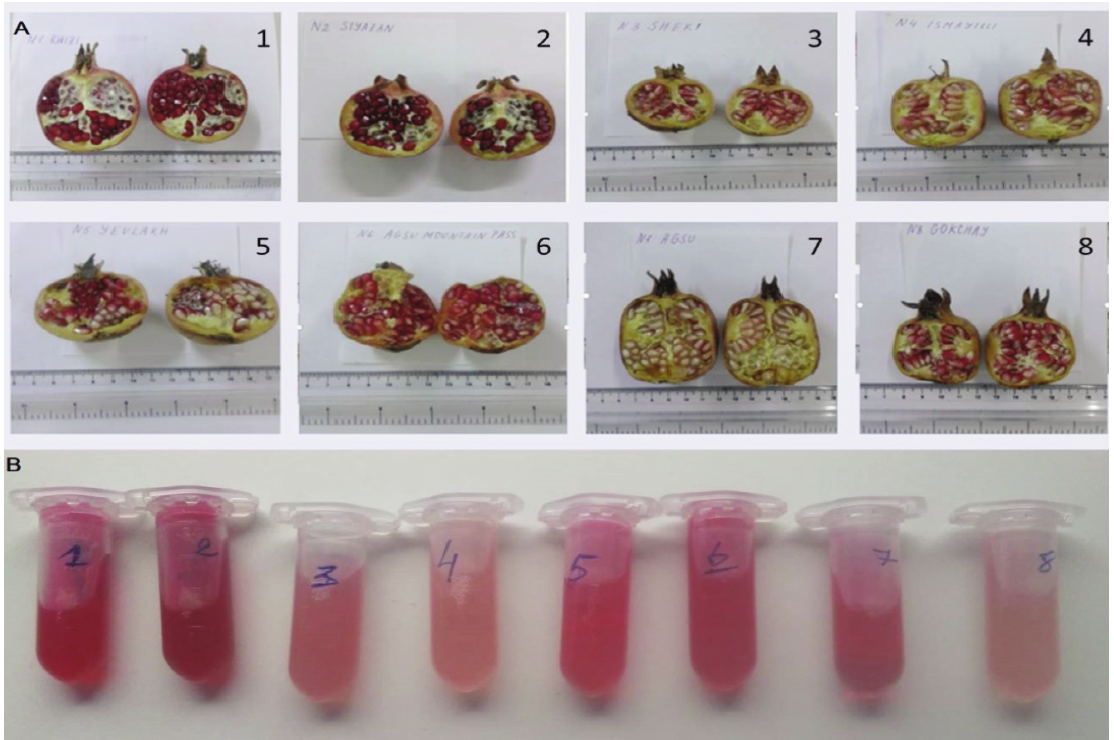
Pel­3­glc=pelargonidin­3­O­glucoside.Fig. 2 ­ A typical fruit harvested in each sampling area (A) and an aliquot of the corresponding extracted juice (B).